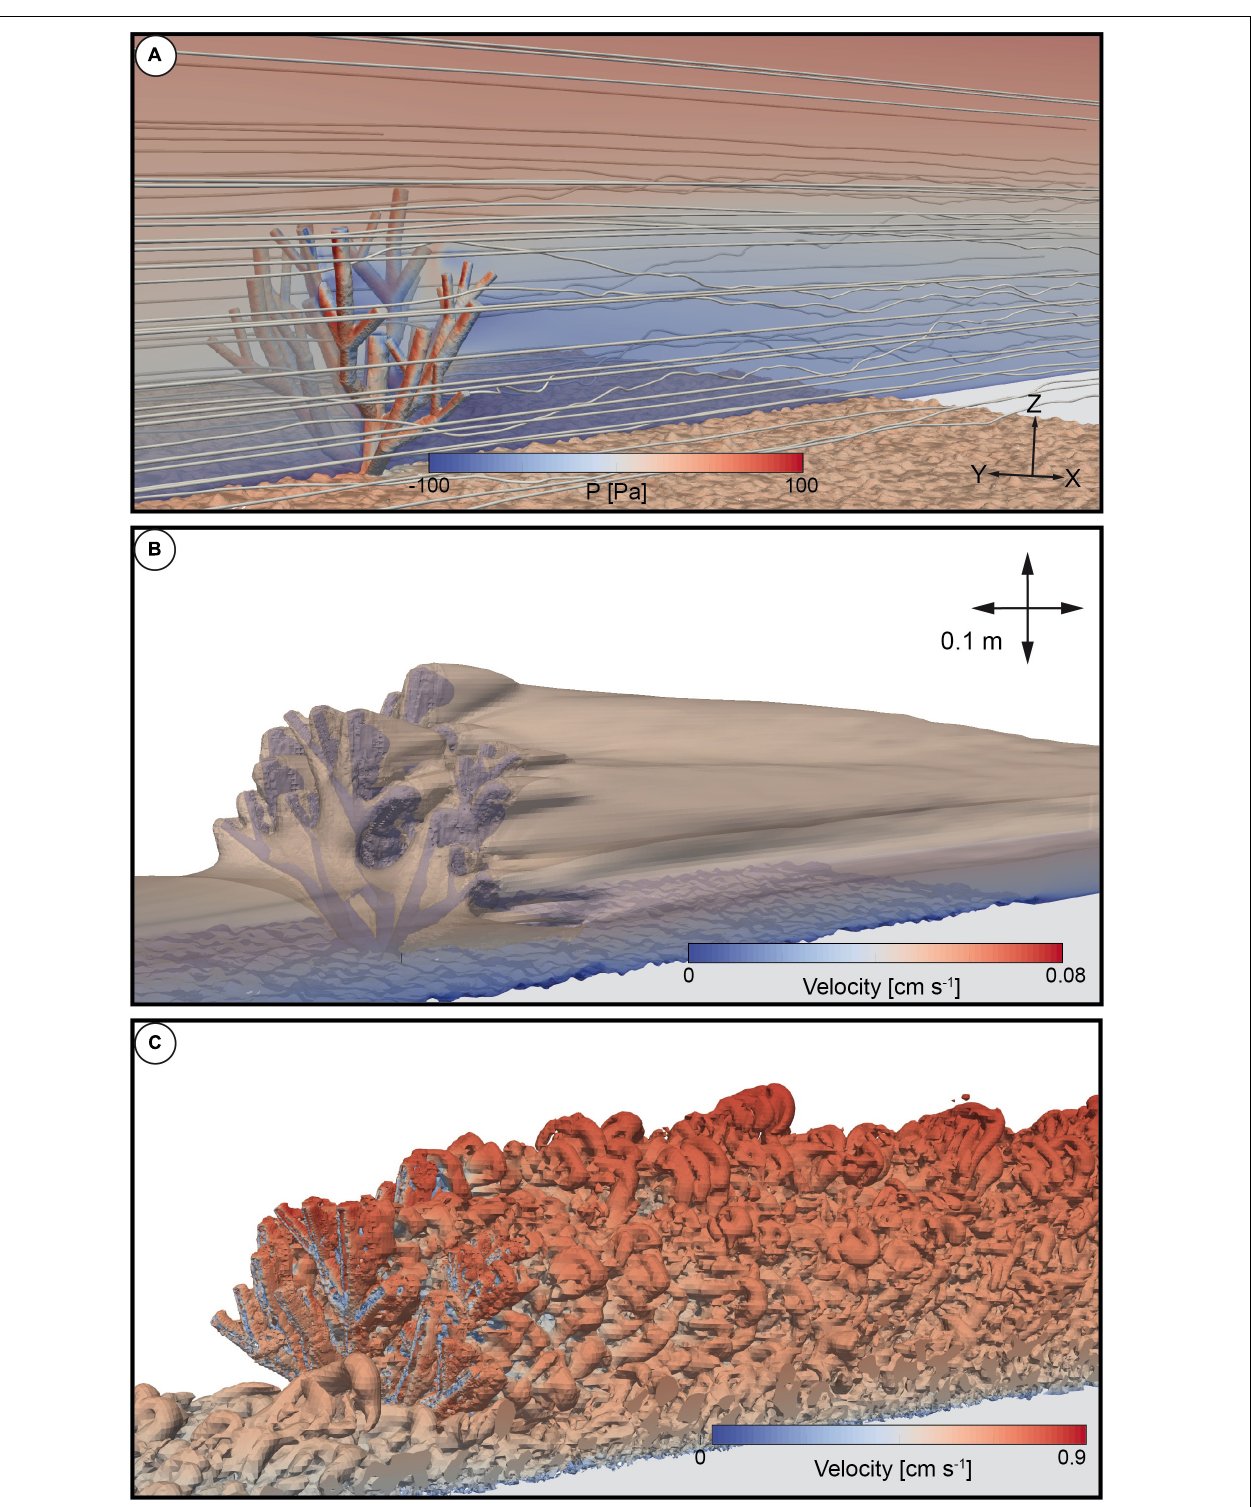
FIGURE 3 | (A) Rendered 3D image of the streamlines and pressure drag values affecting the cold-water coral model as well as roughness elements at the bottom of the domain. The transparent 2D slice in the center of the domain indicates the flow field. (B) Rendered isosurface, indicating flow velocity values of 0.08 m s – 1 . (C) Rendered isosurface indicating the